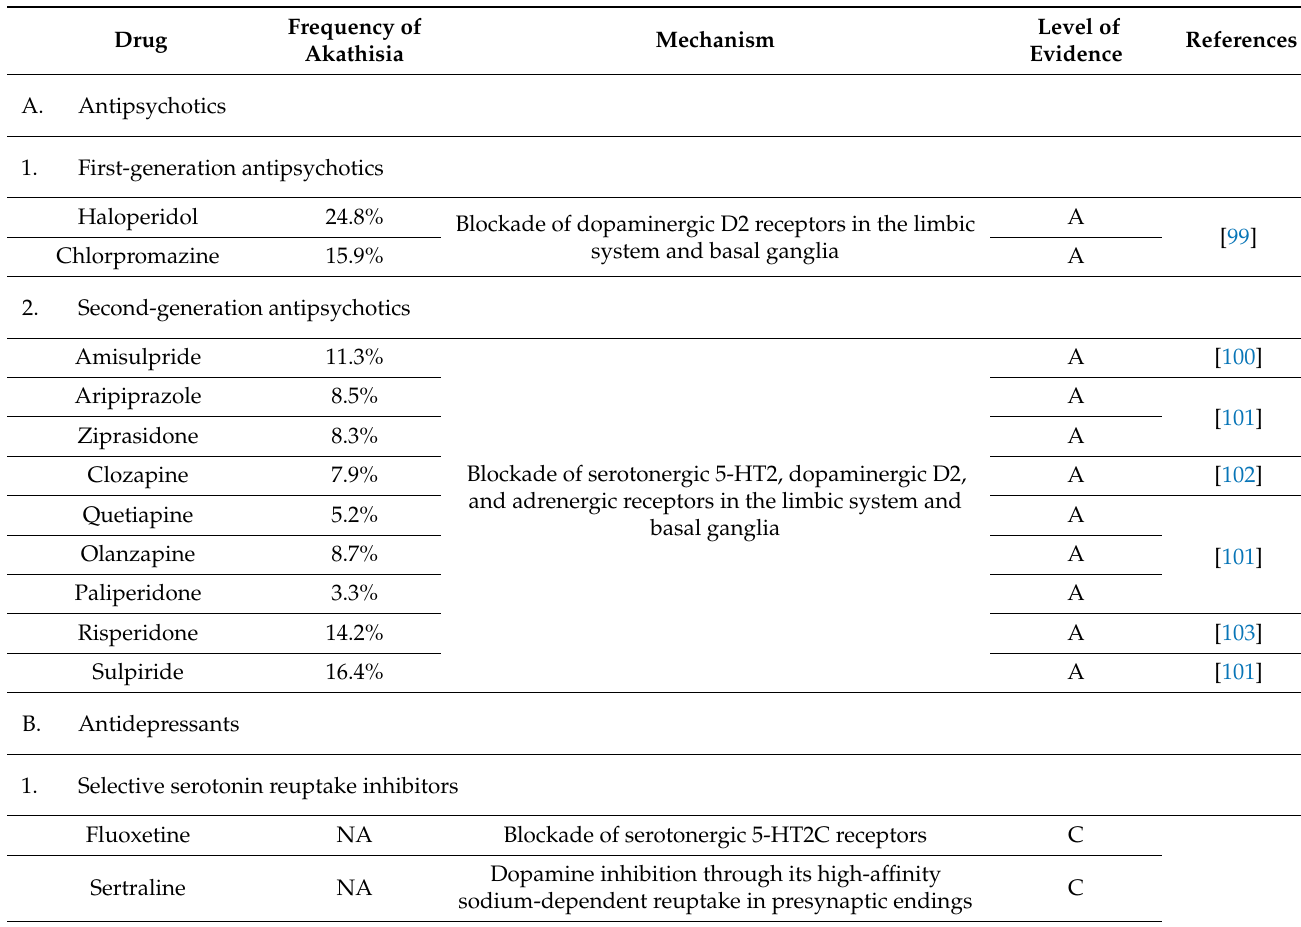
Table A2. List of drugs which predispose patients to drug-induced